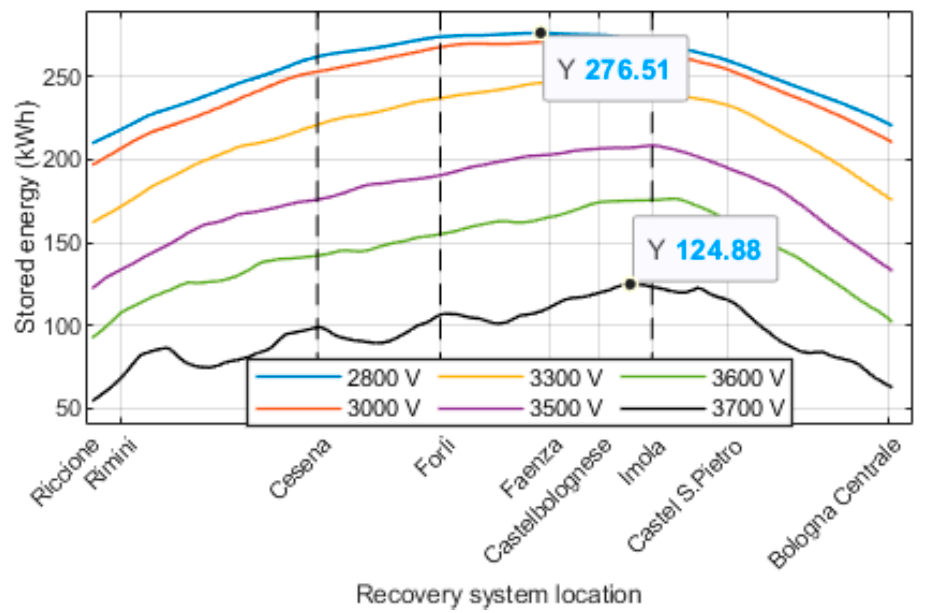
Figure 5. Stored energy vs. ESS location for different value of substation voltage.